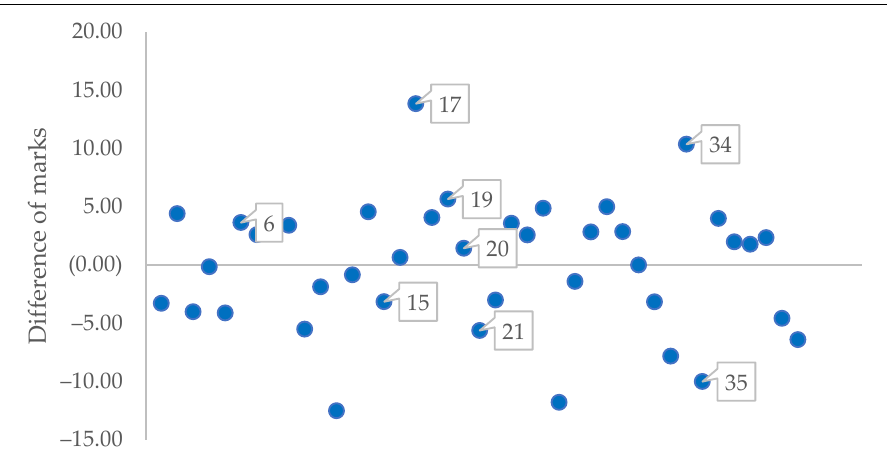
Figure 5. The difference of marks between the student and the student’s peer tutors.